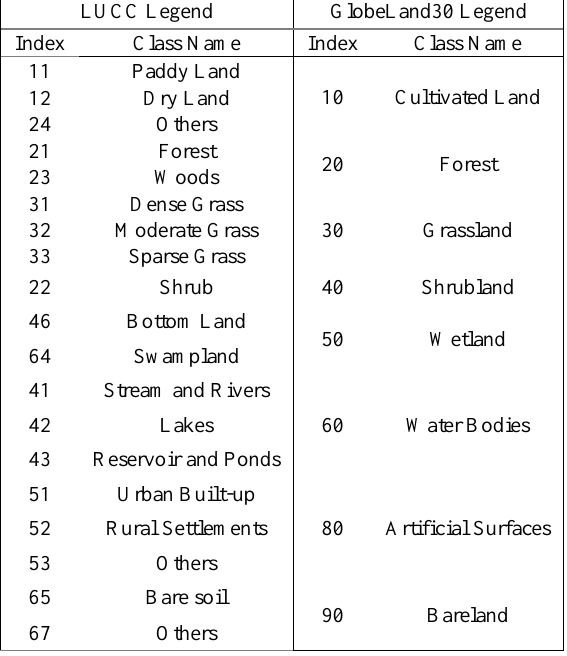
Table 1. Land type reclassification and corresponding relation